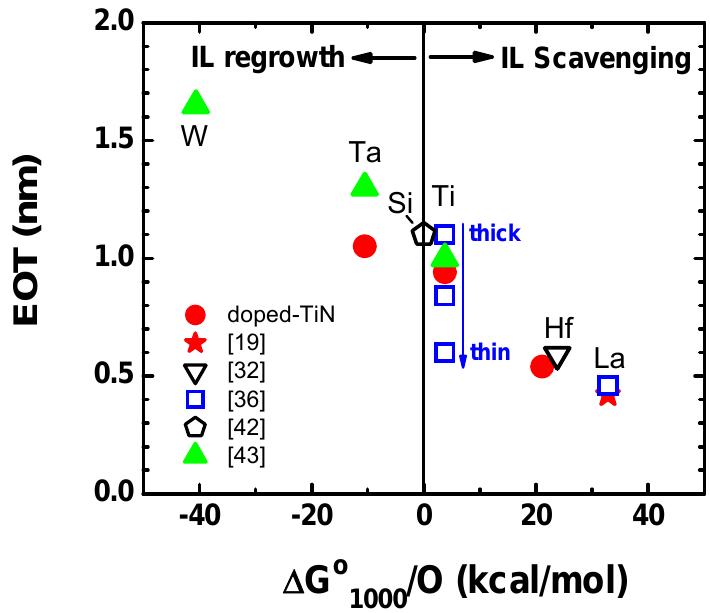
Figure 2. EOT of SiO /HfO metal-inserted poly-Si stack (MIPS) structure as a function of 2 2 Δ G 0 per oxygen atom for scavenging element. TiN electrodes doped with various 1000 metals are compared with literature data (after [19,32,36,42,43]). The Δ G 0 after